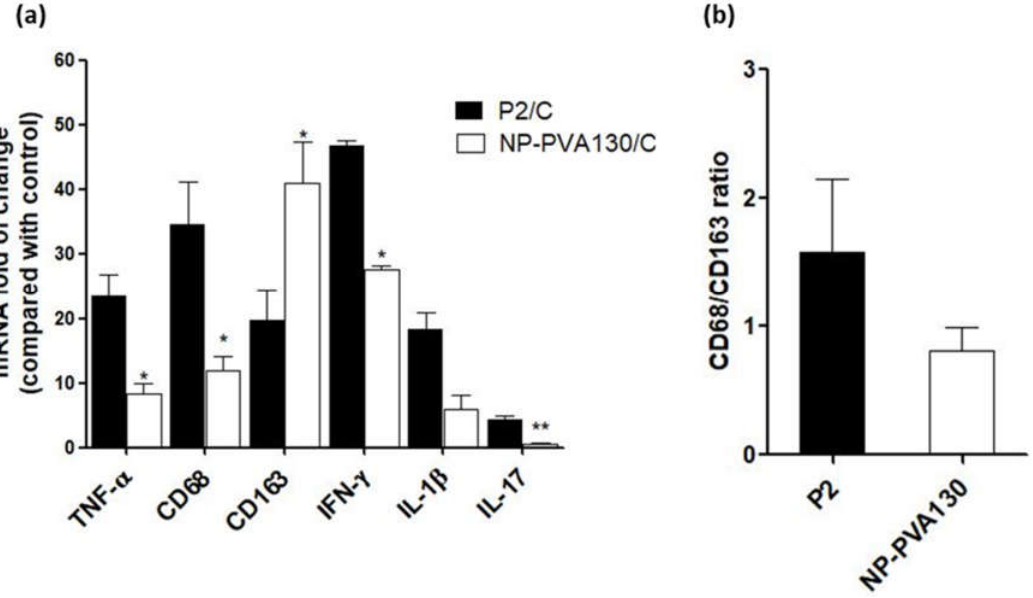
Figure 5. Treatment with NP-PVA-130 attenuated the expression levels of pro-inflammatory mark- ers and increased the expression levels of anti-inflammatory markers. ( b ) mRNA expression ratio of CD68/CD163. ( n = 3), t -test (unpaired) * p ≤ 0.05, ** p ≤